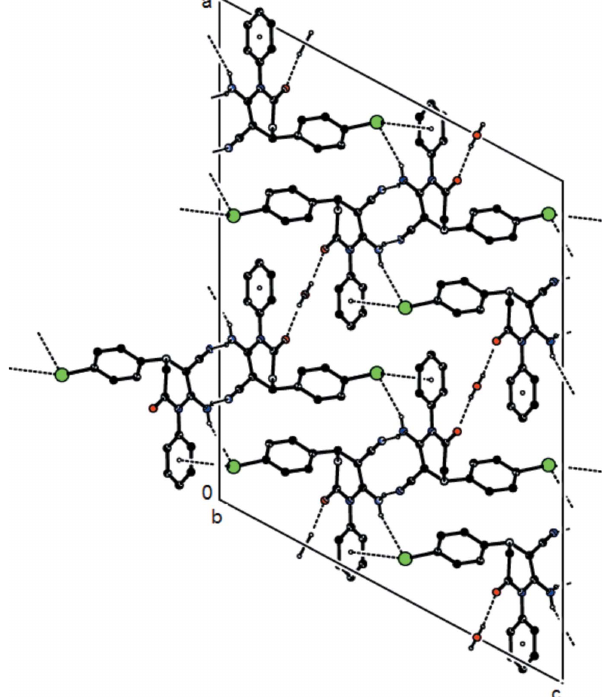
Figure 5 View down the b axis of compound (II) showing the C—H (cid:2)(cid:2)(cid:2) (cid:2) and C— N (cid:2)(cid:2)(cid:2) (cid:2) hydrogen bonds (dashed lines). The intramolecular C—N (cid:2)(cid:2)(cid:2) (cid:2) interaction in molecule IIA is omitted for clarity.